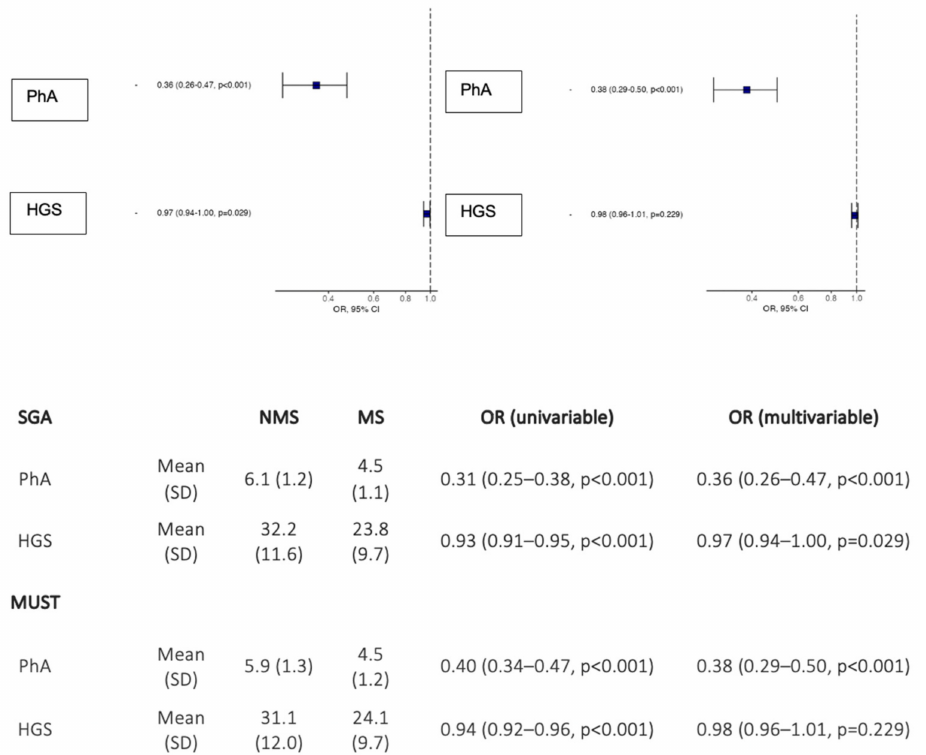
Figure 1. Associations of PhA and HGS with malnutrition tools. Abbreviations: NMS (non–malnutrition status); MS (malnutrition status); OR (odds